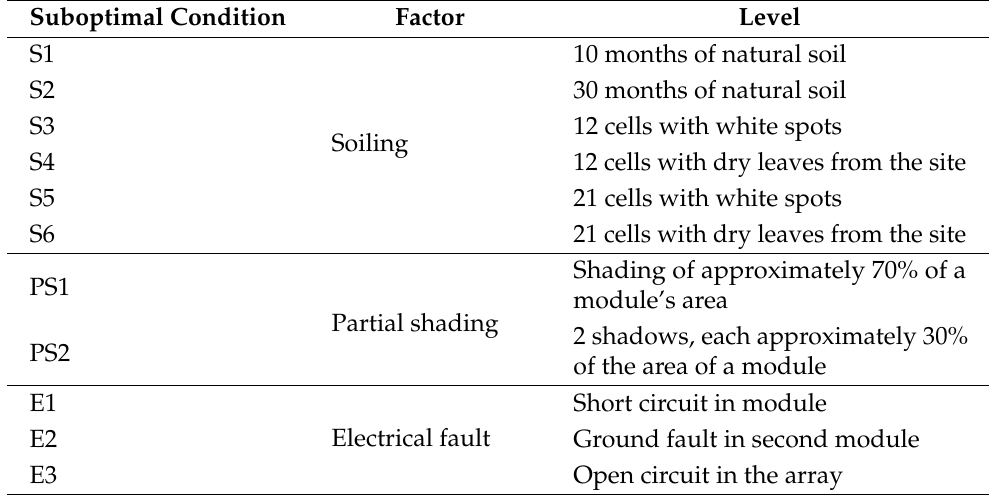
Table 4. Factors (types of failures) and levels used to generate the diverse suboptimal conditions to be evaluated in the